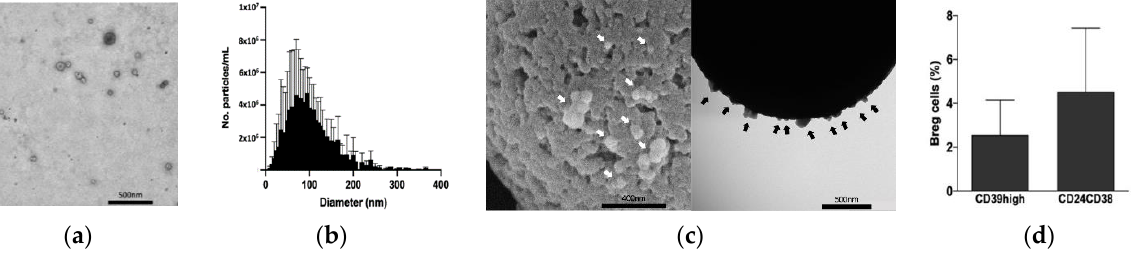
Figure 1. ( a ) Representative transmission electron microscope (TEM) image of exosomes isolated by size-exclusion chromatography and differential centrifugation from the HNSCC PCI-13 cell culture. ( b ) Size analysis of biological triplicates of four exosome isolates from the HNSCC PCI-13 cell culture shows the typical size range of exosomes (30–150 nm). Mean peak vesicle size with standard deviation: 89.47 ± 26.11 nm. Measurements were acquired using the ZetaView ® nanoparticle tracking analyzer (Particle Metrix). ( c ) Representative TEM images of Dynabeads ® with bound CD81+ exosomes (arrows) that were isolated from the HNSCC PCI-13 cell culture. Exosomes were isolated by size-exclusion chromatography and differential centrifugation, immunolabeled with anti-CD81 antibodies coupled to Dynabeads ® , and imaged by TEM. ( d ) Mean of three flow cytometric experiments with standard deviation. A separate analysis of the CD39high and the double-positive CD24+/CD38+ B-cell populations after gating for CD20+ cells. Samples were from three different tumor samples of HNSCC patients.